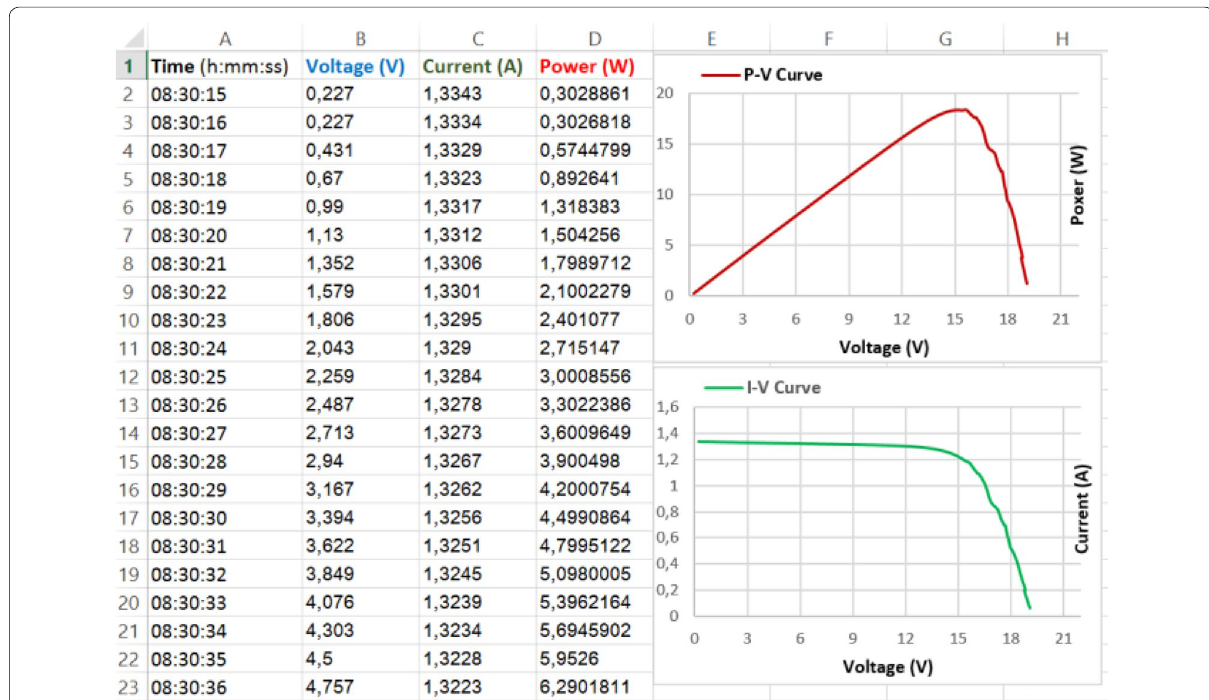
Fig. 14 A sample of experimentally measured data with real-time virtual instrumentation system